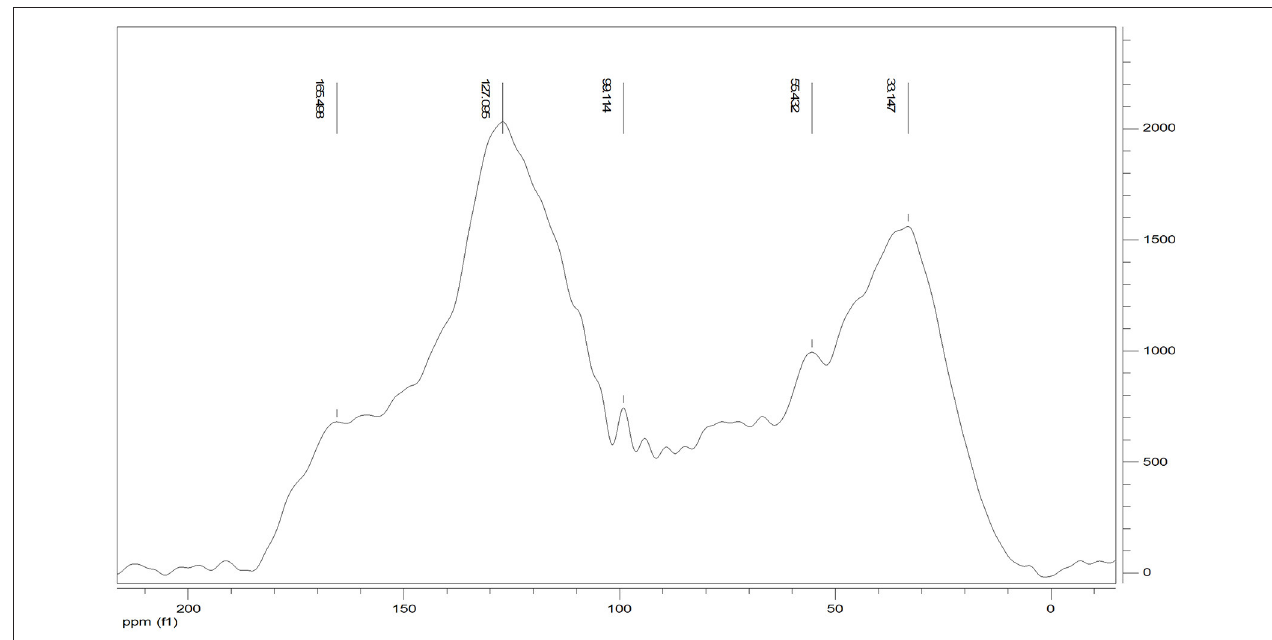
FIGURE 4 | 13 C CPMAS NMR spectrum of Idaho HA.